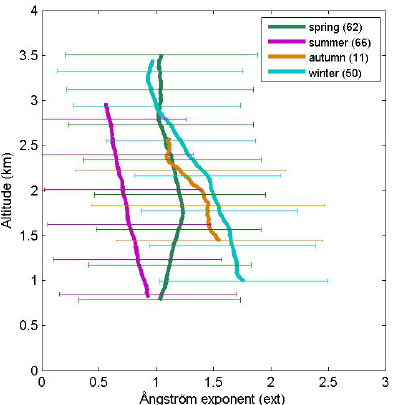
Fig. 7. Seasonal averaged ˚Angstr¨om exponent for extinction (AE ext 355 − 532 ) with standard deviations. The value in the legend indicates the number of profiles used in